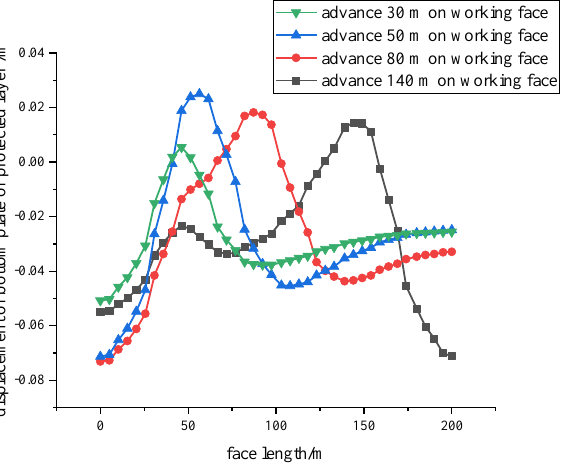
Energies 2022 , 15 , x FOR PEER REVIEW 11 of 20 Figure 11. Pressure relief rate diagram of working face propulsion at different distances. 4.5.2. Analysis of Expansion Rate of Protected Layer in Mining Due to the pressure relief caused by the exploitation of the protective layer, the top and bottom floor of the protected layer will experience displacement. The expansion rate is used to determine the expansion size of the protected layer, and the formula is as fol- lows: / L M = (4) Where:  represents the expansion rate of the protected layer, L represents the dis- placement difference between the top and bottom of the protected layer in the mining process, and M represents the thickness of the protected layer before mining. Based on the coal and rock mass displacement diagram in Figure 6, the displacement variation diagrams of the top and bottom of the protected layer in Figures 12 and 13 can be obtained. The obtained data are then substituted into the above formula, and the ob- tained expansion rate is used to create the expansion rate curve of the protected layer after mining, as shown in Figure 14. It can be seen from the above figure that, in the process of mining the protective layer, the roof and floor of the coal seam under protection are subjected to pressure relief, re- sulting in displacement differences, and the overall expansion rate of the protected layer